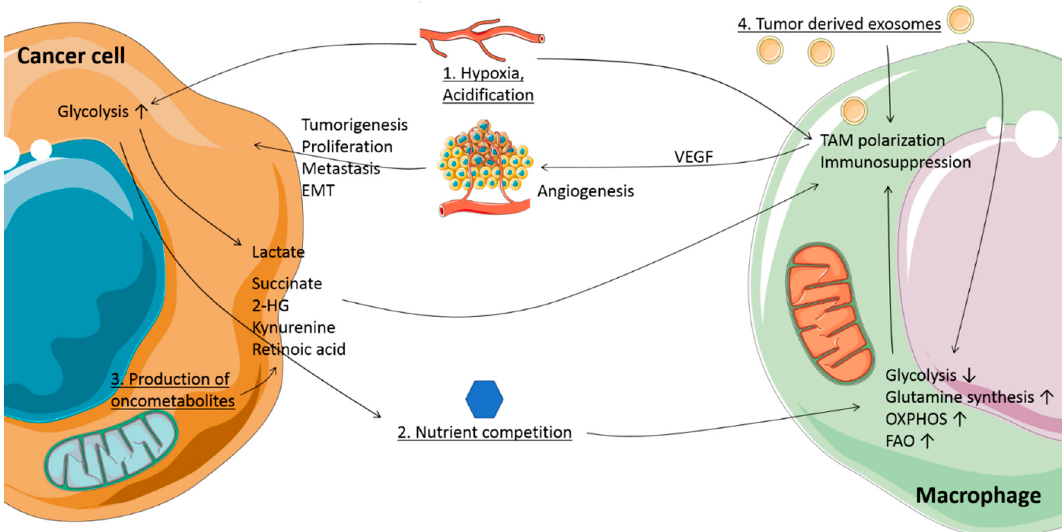
Figure 1. Metabolic conditions and crosstalk between cancer cells and macrophages in the tumor microenvironment (TME). 1. Hypoxia: the TME contains regions with reduced oxygen availability. Together with Warburg metabolism, this promotes lactate production in tumor cells by upregulation of glycolysis. Lactate is transported out of the cells and together with the concomitant acidification influences tumor-associated macrophage (TAM) phenotype. 2. Nutrient competition: presence of glucose and amino acids is limited due to the high metabolic rate of cancer cells, inducing metabolic changes in TAMs, and affecting their function. 3. Production of oncometabolites: mutations in tricarboxylic acid (TCA) cycle enzyme genes, as well as changes in metabolism, lead to accumulation of oncometabolites such as succinate, 2-hydroxyglutarate (2HG), lactate, kynurenine, and retinoic acid. When secreted, these oncometabolites support a pro-tumoral TAM phenotype and function. 4. Tumor-derived exosomes: tumors exhibit an increase in exosome release, which can carry microRNA, oncometabolites and metabolic enzymes, affecting macrophage function and metabolism. Together, these metabolic conditions and oncometabolites induce tumor-supporting TAMs, with functions such as promoting angiogenesis, metastasis, epithelial-to-mesenchymal transition (EMT), proliferation and immunosuppression.